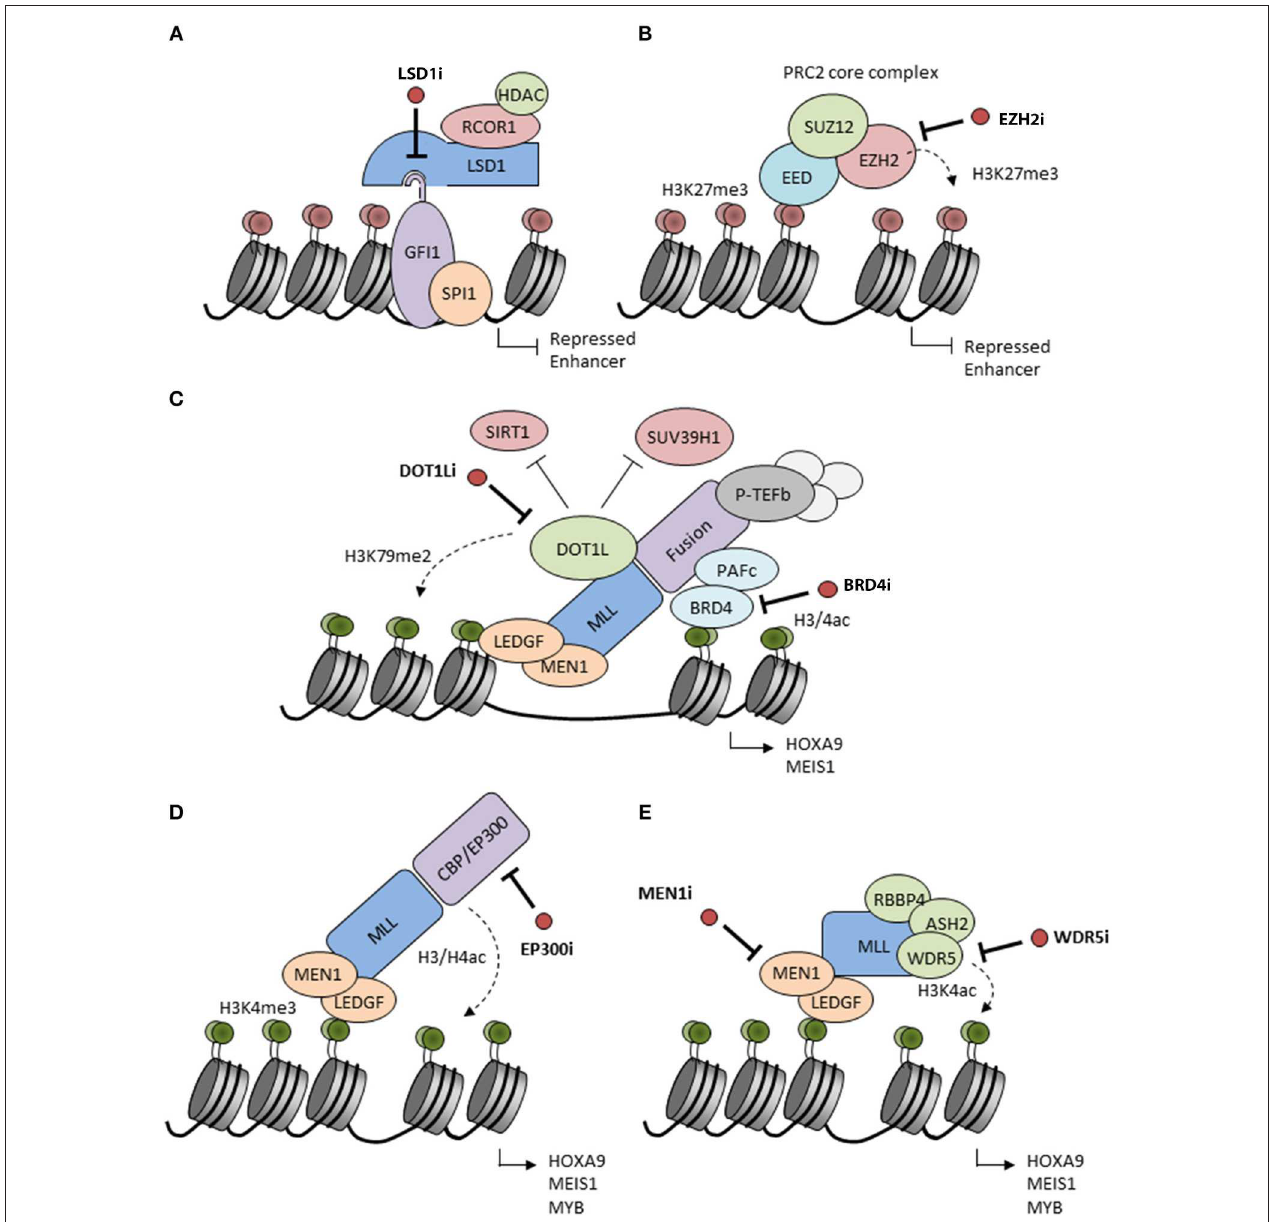
FIGURE 1 | Putative mechanisms of action of candidate epigenetic inhibitors. (A) LSD1 interacts with the SNAG domain of GFI1 recruiting repressors to chromatin. Inhibitors of LSD1 (LSD1i) disrupt the interaction and inactivate GFI1 leading to enhancer acetylation and activation. LSD1 inhibitors also inactivate the histone demethylase activity of LSD1 (not shown). (B) EZH2 catalyzes H3K27 methylation inducing transcriptional repression. This activity is blocked by S-adenosyl-methionine (SAM)-competitive inhibitors of EZH2 (EZH2i). (C) MLL fusion proteins form complexes on chromatin with Polymerase Associated Factor complex (PAFc) (which recruits Super Elongation Complex components), Positive Transcription Elongation Factor b (pTEFb) and other factors to facilitate the expression of MLL-driven target genes, such as HOXA9 and MEIS1 . DOT1L is ectopically recruited by MLL fusions and adds activating H3K79me2 marks while reducing H3K9me2 repressive marks by inhibition of SUV39H1 and SIRT1. BRD4 recognizes H3K27ac marks and is essential for recruitment and stabilization of the MLL complex on chromatin. Inhibitors of the enzymatic activities of DOT1L (DOT1Li) or BRD4 (BRD4i) are considered to disrupt the MLL fusion protein complexes leading to the release of the differentiation block. (D) MLL may be fused to the histone acetyltransferases CBP or EP300 which are associated with H3/H4 acetylation and active gene transcription. CBP/EP300 bromodomain inhibition (EP300i) decreases H3K27 acetylation and chromatin accessibility at target promoters and enhancers. (E) The N-terminal part of the MLL complex associates with different proteins, such as LEDGF and Menin which stabilize the complex on chromatin. Proteins, such as RBBP5, ASH2L, and WDR5 interact with the MLL C-terminus to facilitate SET domain-mediated H3K4 methylation. Inhibition of these interactions (MEN1, WDR5i) disrupt the MLL complex and decrease expression of HOXA9 and MEIS1 .